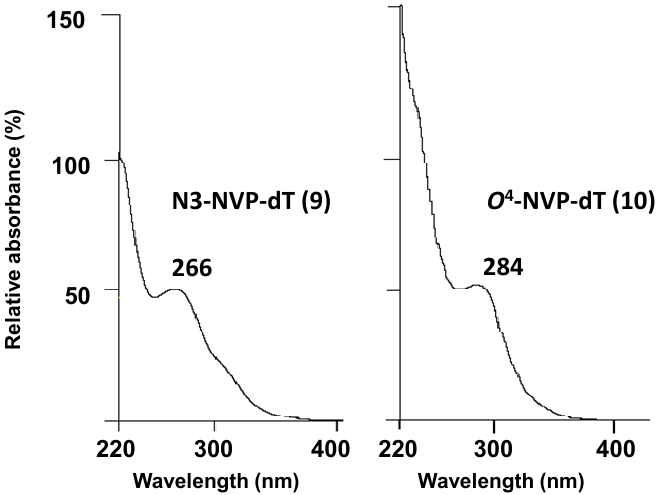
Figure 4. UV spectra of the dT-derived NVP adducts, N3-NVP-dT ( 9 ) and O 4 -NVP-dT ( 10 ), isolated from reaction of 12-bromo-NVP with 3',5'-bis- O -( tert -butyldimethylsilyl)-dT under palladium catalysis. The spectra were obtained online, by HPLC with diode array detection, in acetonitrile/0.1% aqueous formic